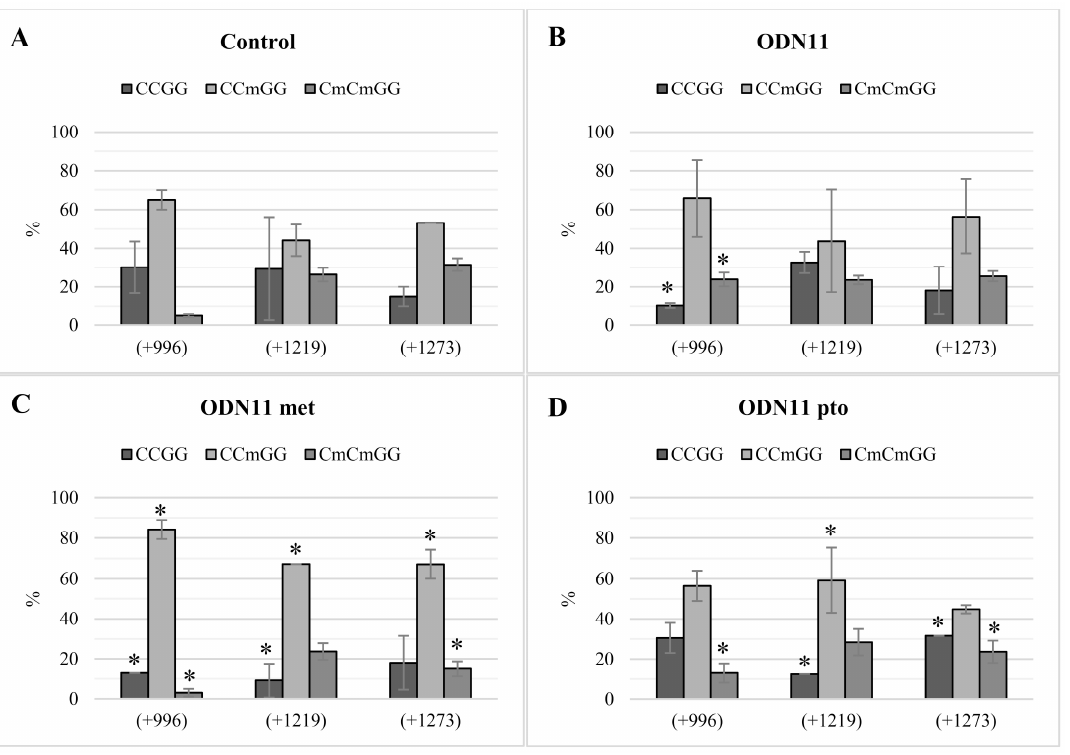
Figure 4. Methylation profiles for variable CCGG motifs in control plants ( A ). Plants treated with unmodified ODN11 ( B ) and modified ODN11 met ( C ) and ODN11 pto ( D ), 10 days after the treatment. The figure presents the percentage of the cytosine methylation in the variable CCGG sites ( + 996, + 1219, + 1273) located in the coding region of the CHS gene sequence. The genomic DNA was digested by restriction enzymes HpaII and MspI. The amount of non-digested DNA was determined by real-time PCR. The percentage of particular modification was presented for studied plants and control: CCGG—lack of methylation (dark grey), CCmGG—methylation of internal cytosine (light grey) and CmCmGG—methylation of both cytosines (medium grey). The site positions were presented according to the LuCHS6 sequence, due to the presence of all CCGG sites. Data represent the mean value ± SD from at least three independent experiments. The significance of the differences between each mean and control was determined by Student’s t -test. Asterisk indicates * p < 0.05.